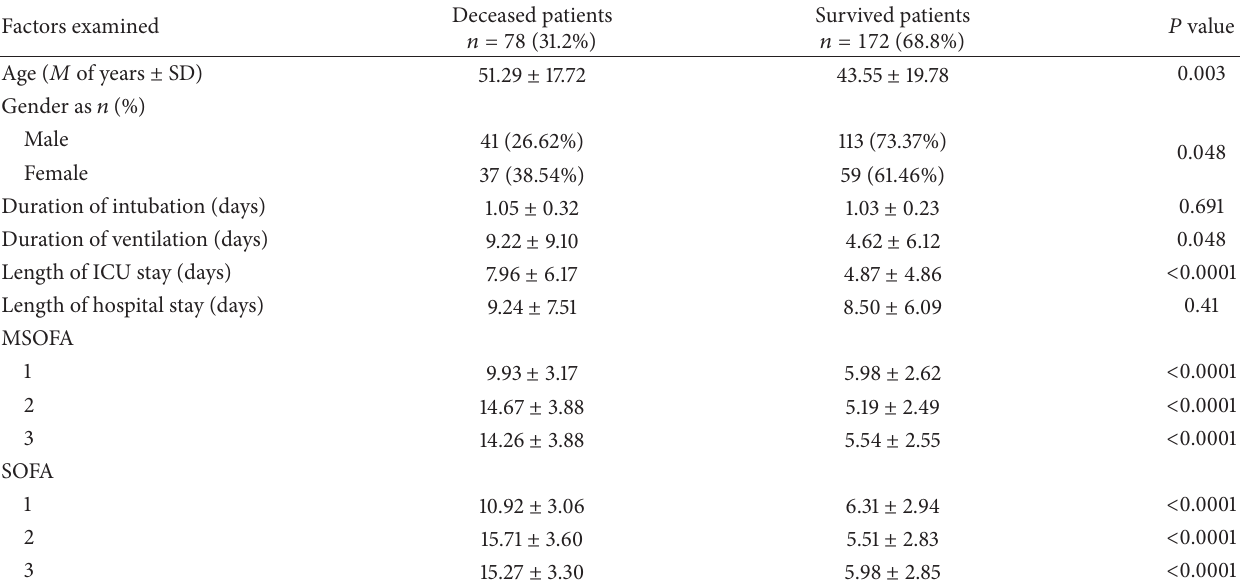
Table 2: Comparison of demographic data, clinical findings, and SOFA-MSOFA scores.